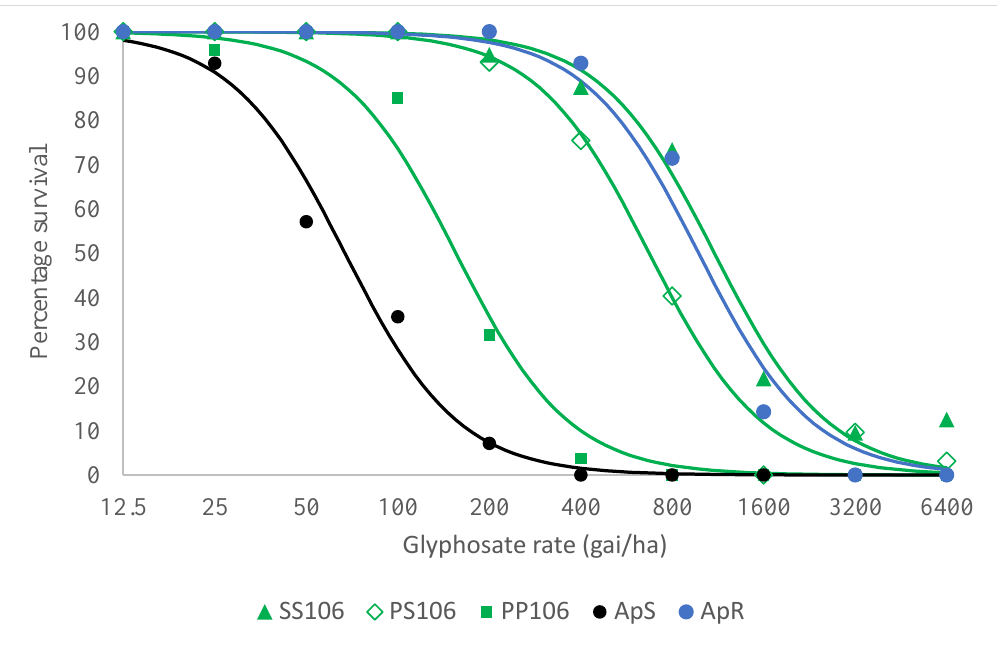
Figure 2. Glyphosate whole-plant dose–response assay on five A. palmeri populations: ApS (standard sensitive), ApR (known resistant due to EPSPS gene duplication) and three characterized subpopulations (homozygous wild-type PP106; heterozygous PS106 and homozygous mutant SS106) arising from a cross between 52 heterozygous PS106 individuals. Dose-response analysis estimated LD 50 values at 67 g ai ha −1 for the standard sensitive population ApS to 1102 g ai ha −1 for the homozygous mutant SS106 through to 672 g ai ha −1 for the heterozygous mutant PS106 plants (Table 1a). The corresponding resistance indices for PS106 and SS106, computed relative to PP106 plants originating from genetically comparable VM1-P individuals were 4.3 and 7.1, respectively (Table 1b).